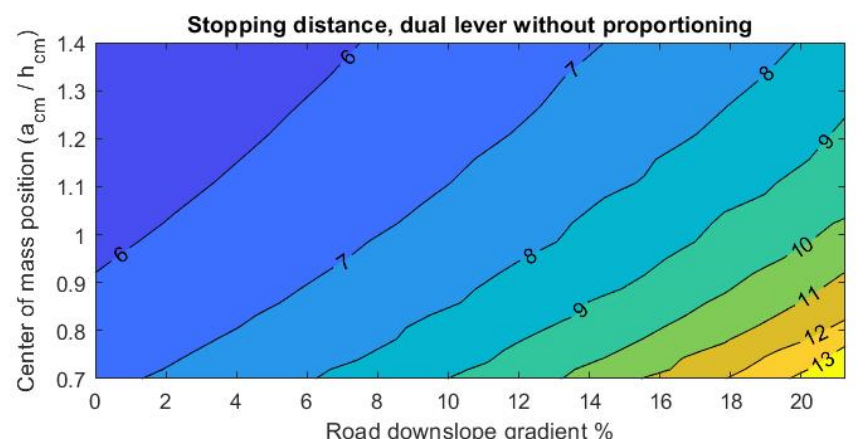
Figure 14. Percent decrease in stopping distance for the prototype brake system showing an in- creased advantage for high centers of mass and when riding on steeper downslopes.